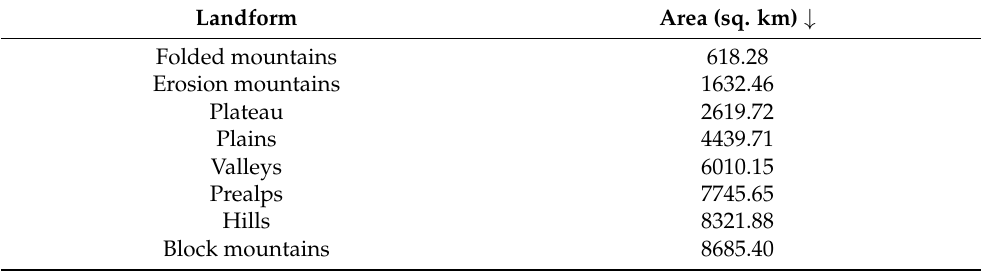
Table 4. Areas covered by landforms in Switzerland.